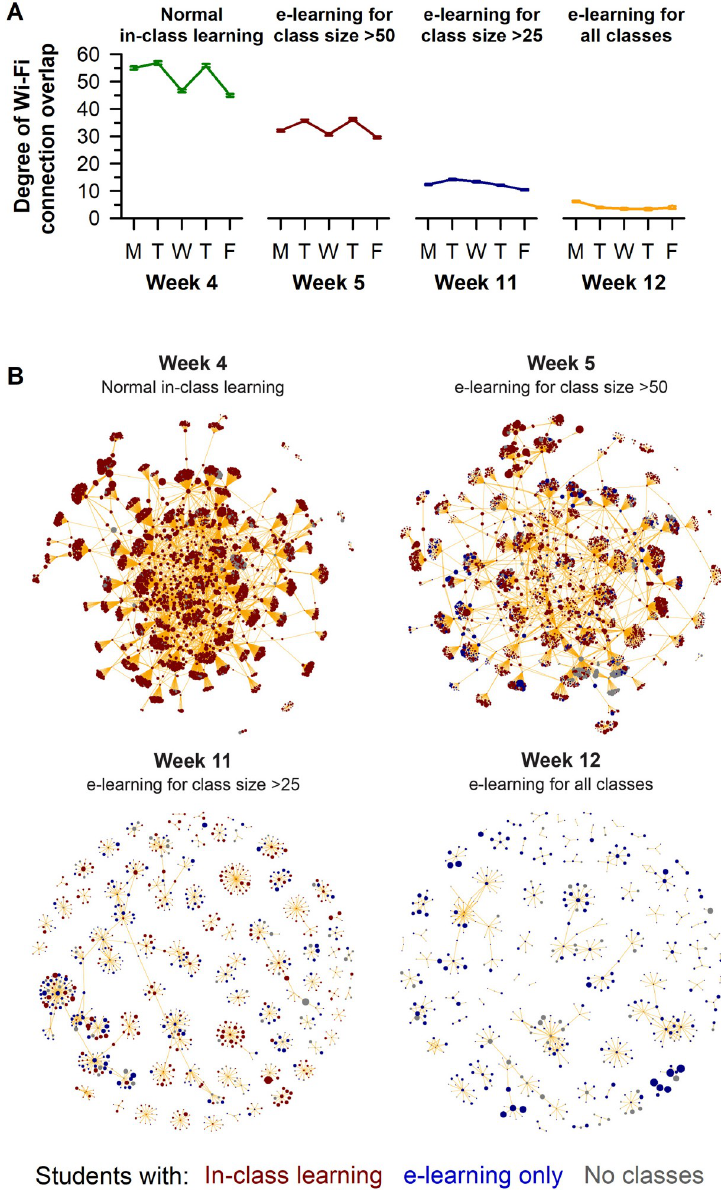
Fig 3. E-learning interventions reduced the number of pairs of students with spatiotemporal overlap during the COVID-19 outbreak. ( A ) Each e-learning intervention was associated with a decrease in the degree of Wi-Fi connection overlap per student. ( B ) Network plots for 100 randomly selected students show that more stringent e- learning policies resulted in a sparser network structure with smaller clusters of students. In panel A , the mean ± 95% CI is shown. In panel B , the size of each circle relates to the daily duration of time connected to Wi-Fi. The thickness of the orange lines corresponds to the duration of spatiotemporal overlap between pairs of students. Data in the network plots correspond to Mondays for each of the representative weeks with different e-learning